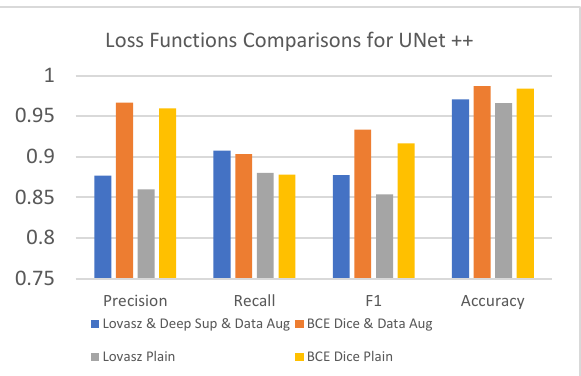
Figure 4: Effect of Data Augmentation (Data Aug) and Deep Supervision (Deep Sup) on UNet++ architecture when training using the BCE Dice Loss.